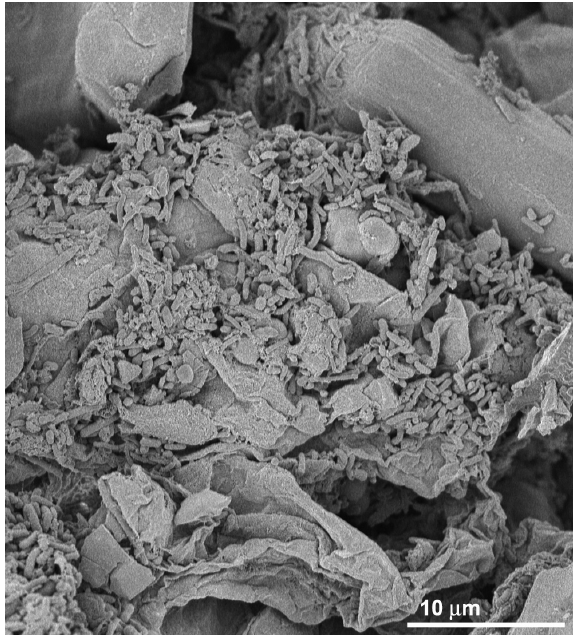
Figure 3 . Scanning Electron Microscopy (SEM) of native sprout microbiota attached to sprout particulate matter. SEM results illustrate the physical complexity of alfalfa sprout samples, show- ing the presence of large sprout particulates with native bacteria attached. These include a palisade parenchyma cell (large colum- nar structure at upper right) and a “ de fl ated ” root or stem struc- ture (bottom center). including palisade parenchyma cells (large columnar struc- ture, upper right hand corner) and stems, roots or the debris from these (collapsed tubular structure, bottom center).